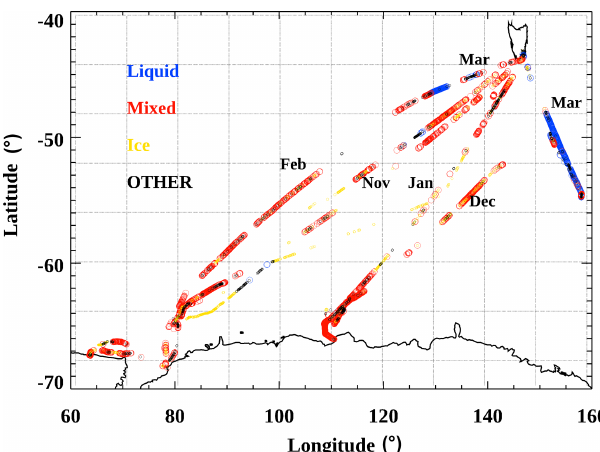
Figure 9. The latitudinal and longitudinal distributions of classi- fied mixed-phase, liquid, and ice clouds in the single-layered, low- level clouds. The liquid (blue), mixed (red), ice (yellow), and other (black) values are shown along each ship track from October 2017 to March 2018 during